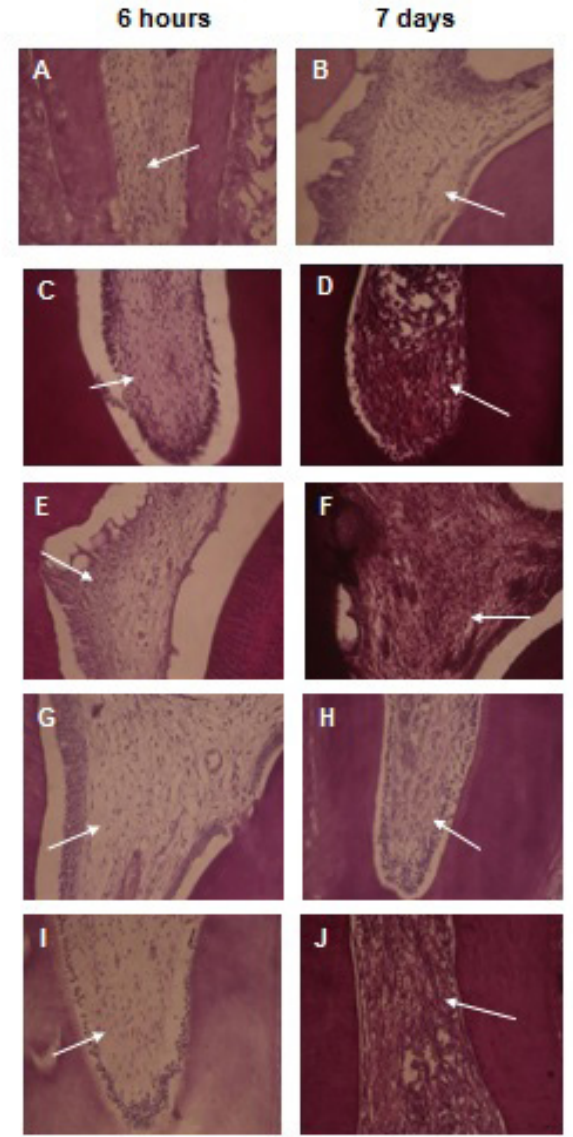
Fig. 2 - Collagen type I density on rats dental pulp tissue after materials test application for 6 hours and 7 days in groups I (A-B), II (C-D), III (E-F), IV (G-H) and V (I-J) with no treatment (negative control), ethanolic extract of propolis (EEP), extract of flavonoid-propolis, extract of non-flavonoid propolis and calcium hydroxide (Ca(OH) ) (positive control), respectively. 2 White arrows show collagen type I. Mallory stain, original magnification 400